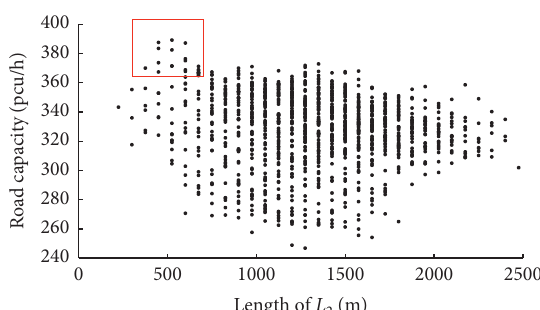
Figure 3: Relationship between road capacity and total length of (trend). road section L 2